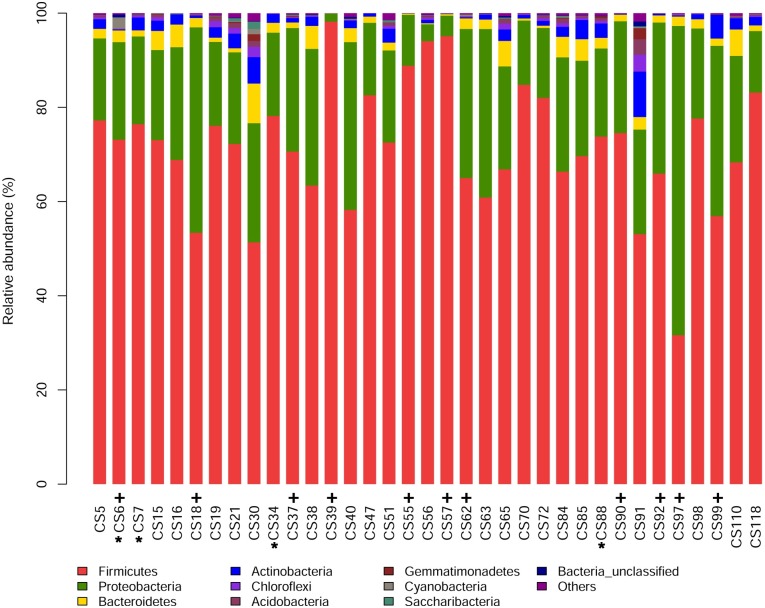
Spleen microbiota compositions at phylum level.Color-coded bar plot showing the proportion of different bacterial phyla present in 35 mouse and shrew samples from Chongming Island, Shanghai city. The 4 shrew samples were marked with *, and the left 31 samples were mice; Samples marked with + were Anaplasma-positive.